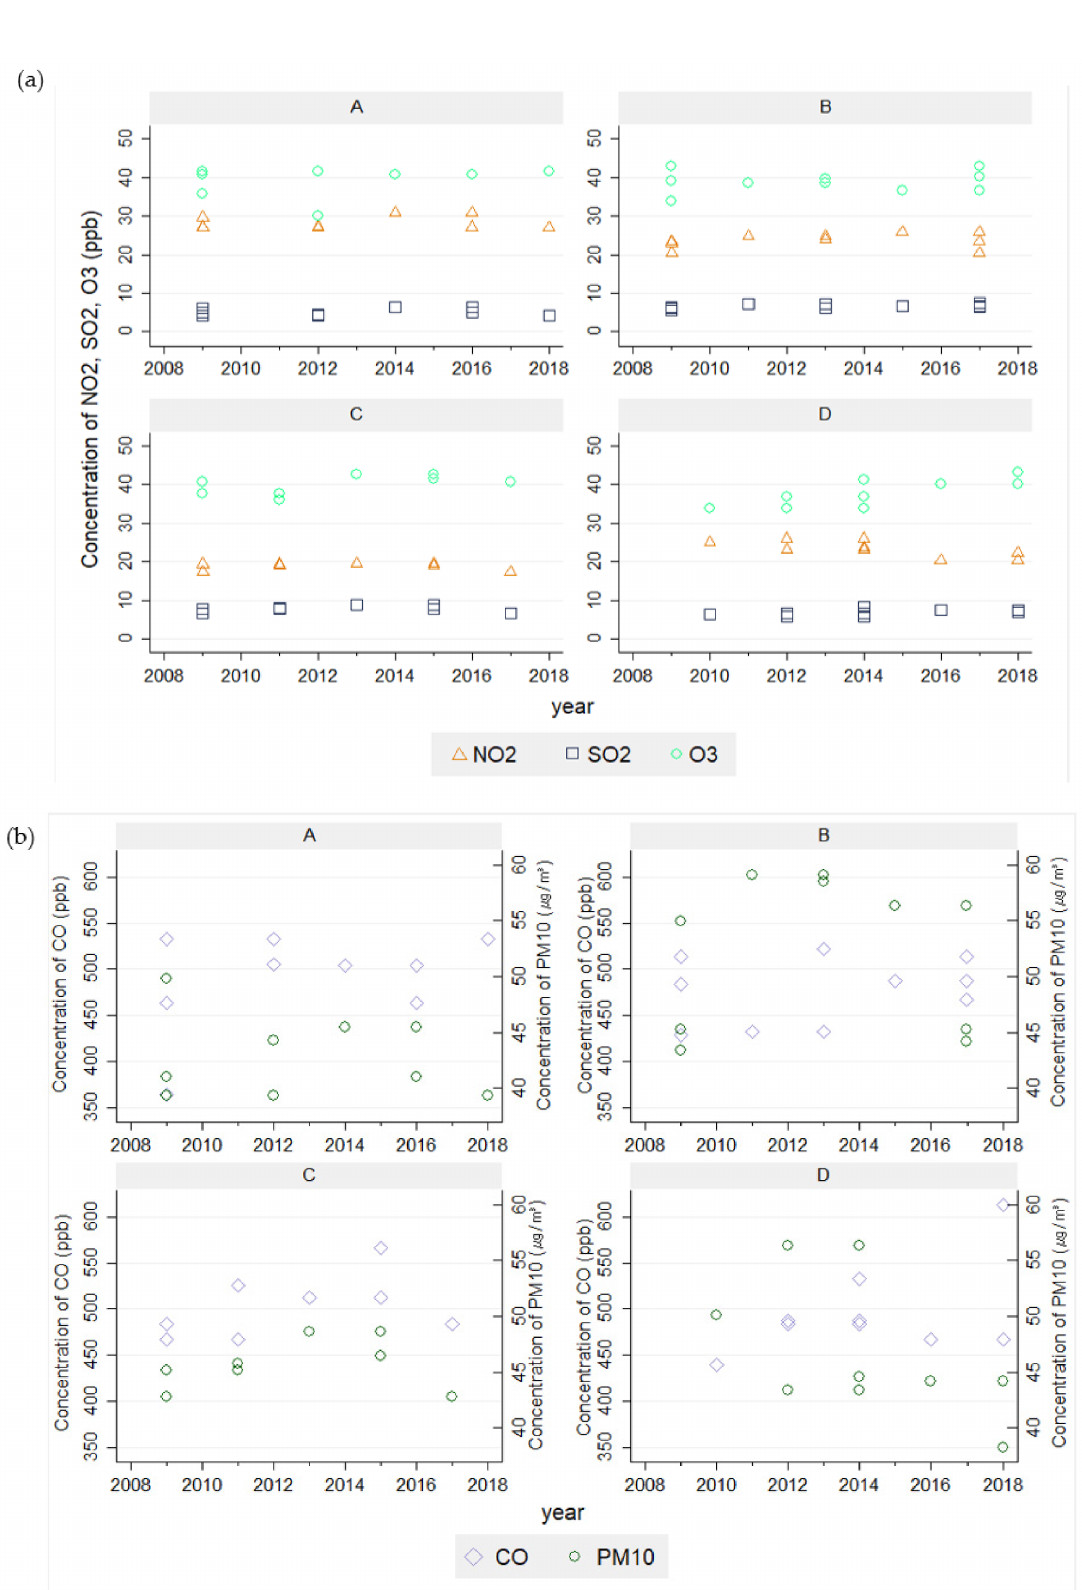
Figure 4. Air pollutant concentration each year by the school; ( A ) represents the coastal environment, ( B ) represents the residential area, ( C ) represents the industrial area, ( D ) represents the downtown area. ( a ) estimated concentration of NO 2 , SO 2 , O 3 without showing a distinct pattern ( b ) estimated concentration of CO and PM10 without showing a distinct